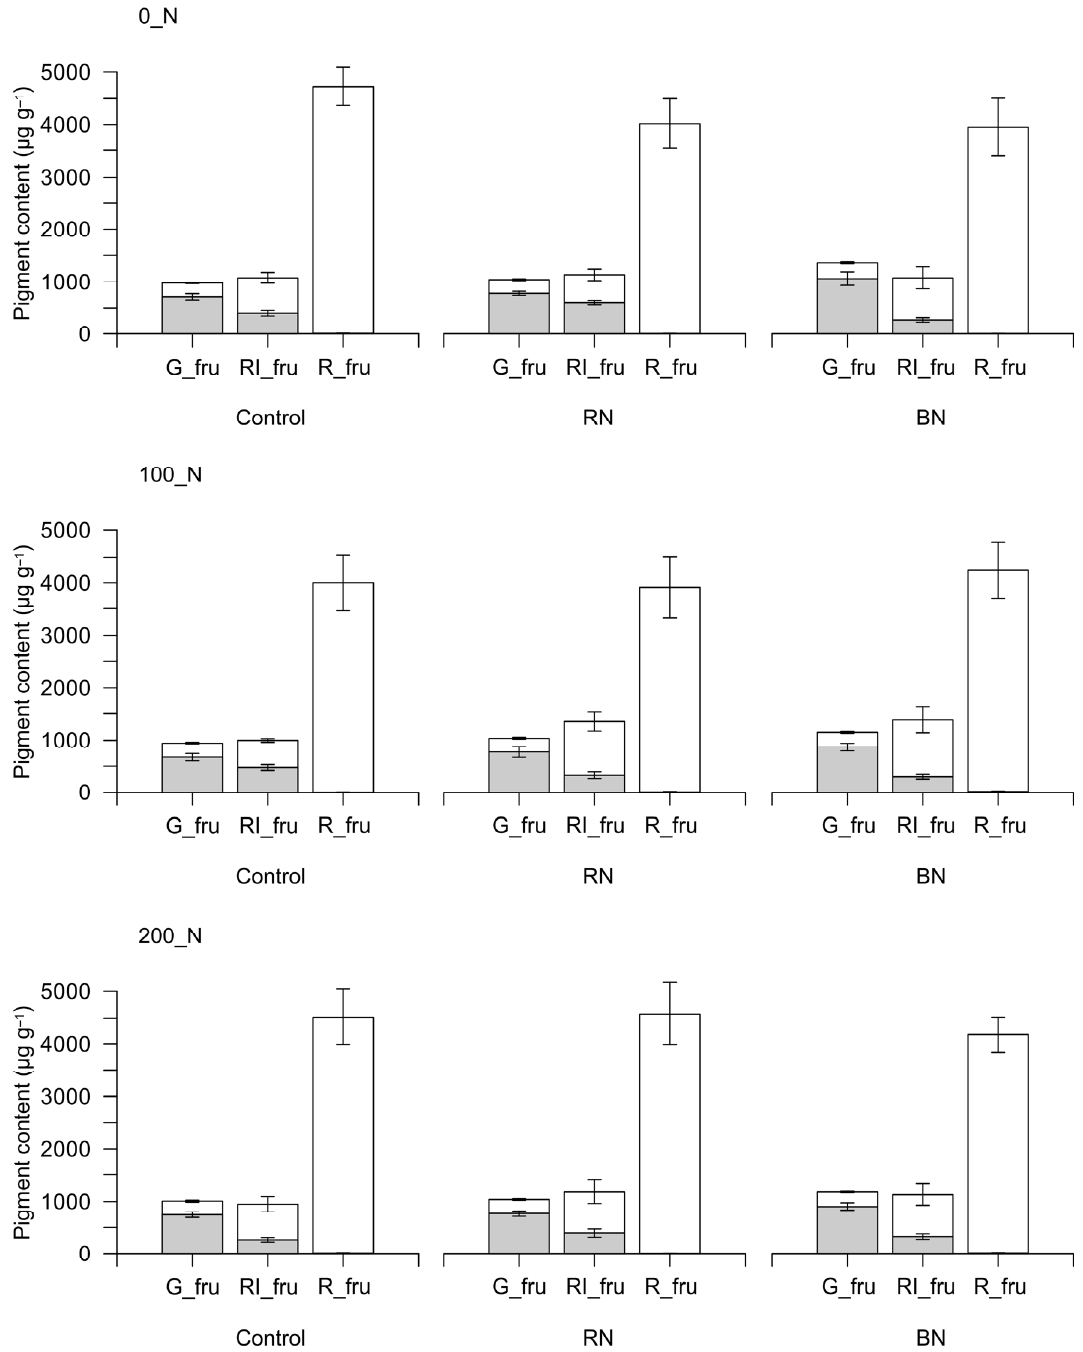
Figure 2. Pigment content ( µ g g − 1 dry weight), as determined in pepper fruits from plants subjected to different N fertilization rates (0_N: 0 kg N ha − 1 ; 100_N: 100 kg N ha − 1 ; 200_N: 200 kg N ha − 1 ) and shade levels (accomplished using: no cover, Control; red photoselective net, RN; black photoselective net, BN) at harvest (83 days after transplanting, DAT), in 2017. Light gray chart: total chlorophyll (Chl TOT) content (Chl A + Chl B); white chart: carotenoids (Car) content. G_fru: green fruits; RI_fru: early-ripening fruits; R_fru: red fruits. Data are means ± standard errors, over Exp_1 and Exp_2 ( n = 6).